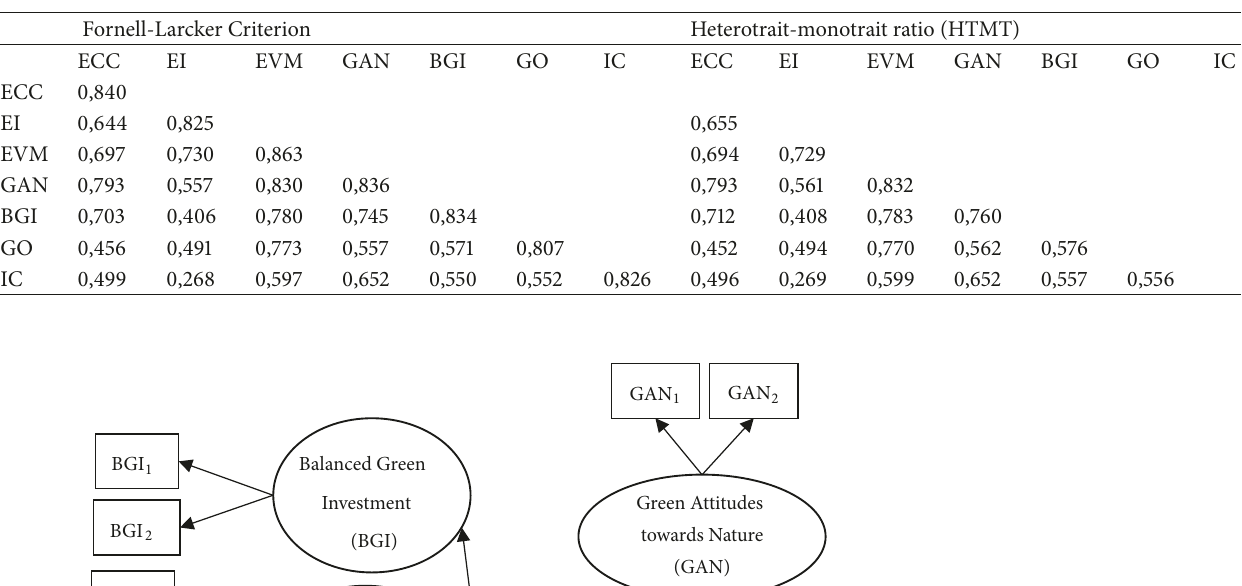
Table 4: Measurement model. Discriminant validity.